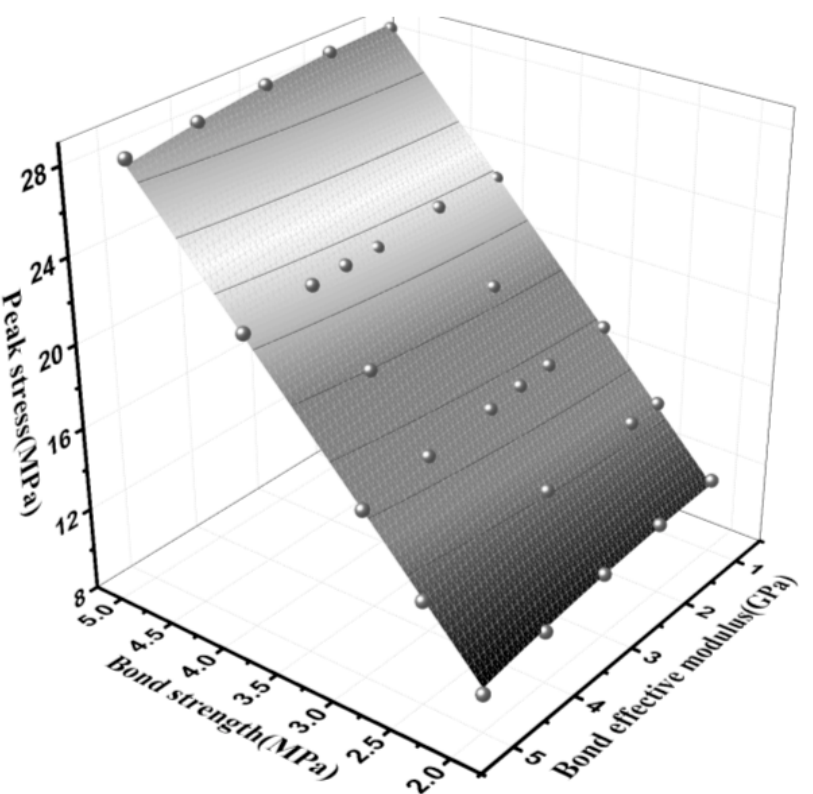
Figure 18. Relationship between bond effective modulus, bond strength and peak stress.